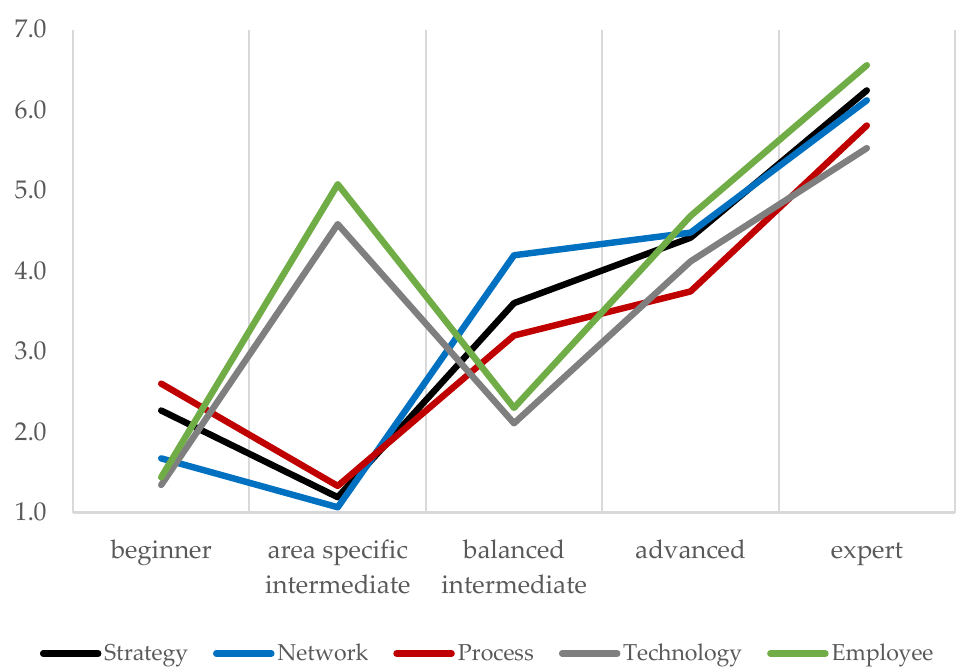
Figure 8. Characteristics of the logistics dimensions in the comparison of clusters.